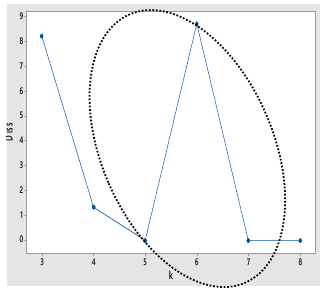
Fig. 2. Scatter plot for Fig. 3. Scatter plot